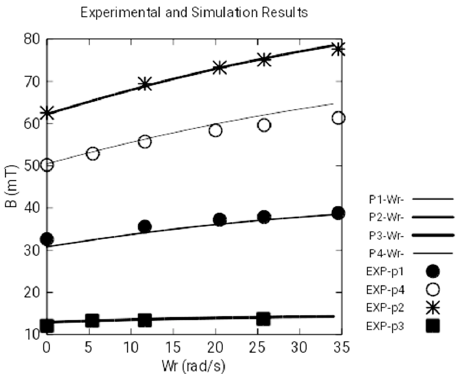
Figure 9. Measurement of the magnetic field with clockwise Wr – .